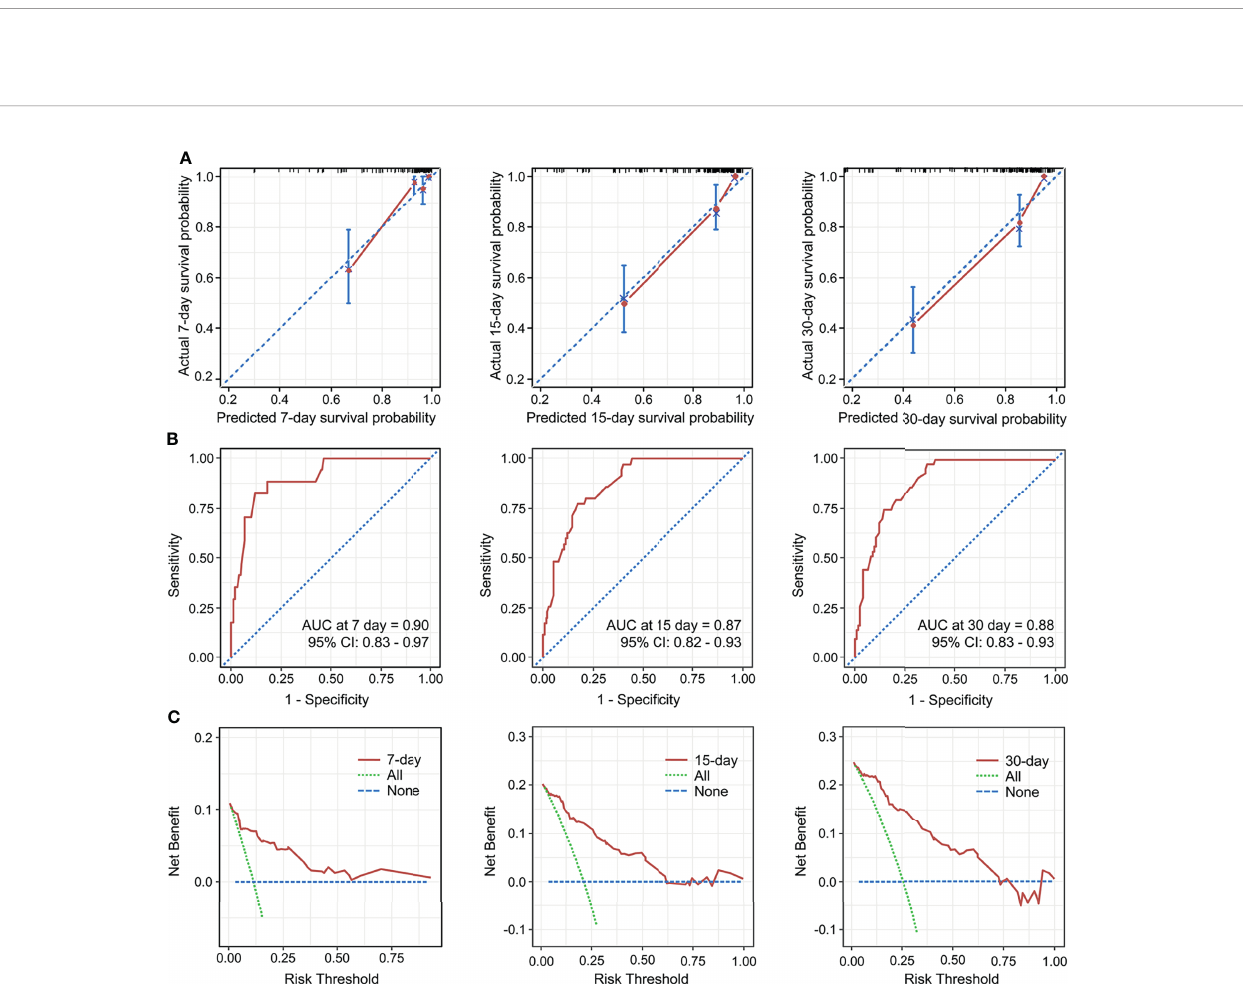
FIGURE 3 | Calibration curves for the nomogram predicting 7-, 15-, and 30-day mortality (A) . AUC of time-dependent receiver operating characteristics (ROC) curves for predicting 7-, 15-, and 30-day survival (B) . Decision curve analysis for the 7-, 15-, 30-day survival nomogram (C) . CI, con fi dence